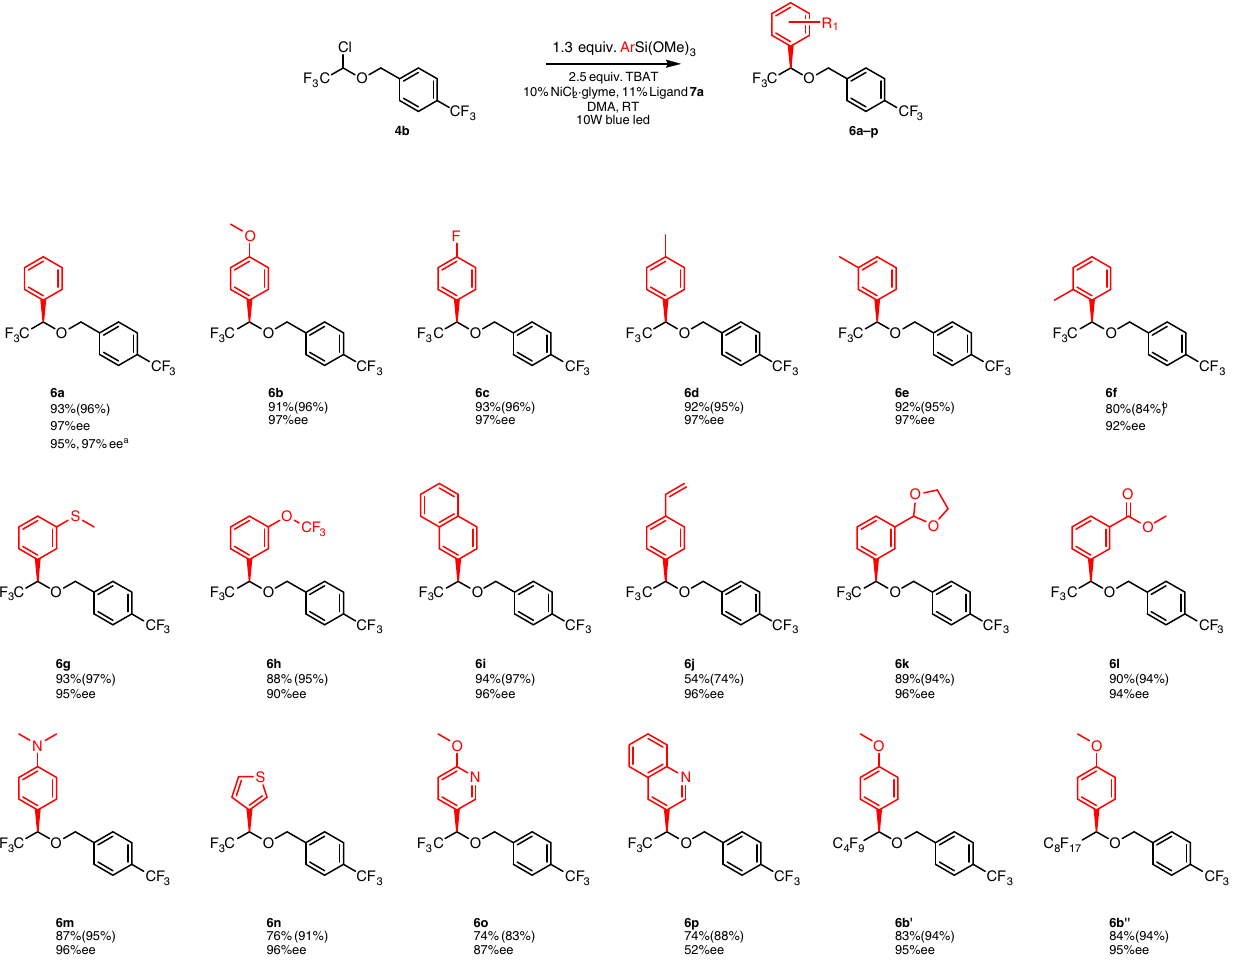
Fig. 3 Examples of the Hiyama cross-coupling reaction with aryl silanes. Various aryls and heterocycles can be introduced. Isolated yield is reported ( 19 F NMR yield is given in brackets). Reaction conditions: 4b (1 equiv.), (hetero)aryltrimethoxy silane (1.3 equiv), TBAT (2.5 equiv.), NiCl 2 ·glyme (0.1 equiv.), Ligand 7a (0.11 equiv.), DMA, room temperature, 10 W blue led. a Reaction on 2 g scale of 4b ; b reaction time 48